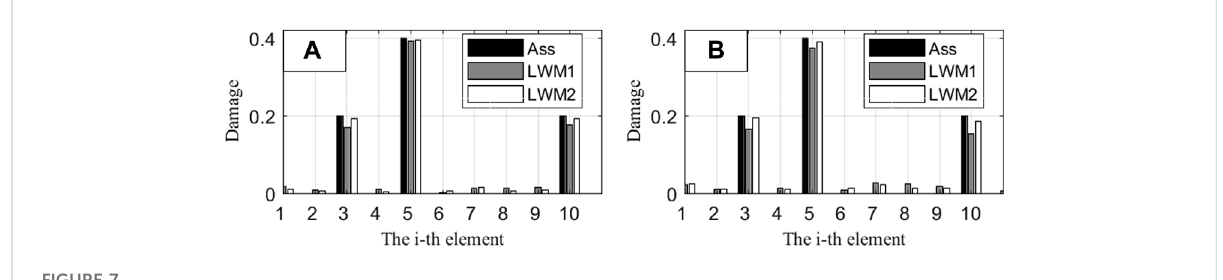
FIGURE 7 SSDD results in case 3 with noise contamination (A) Noise level 1%. (B) Noise level